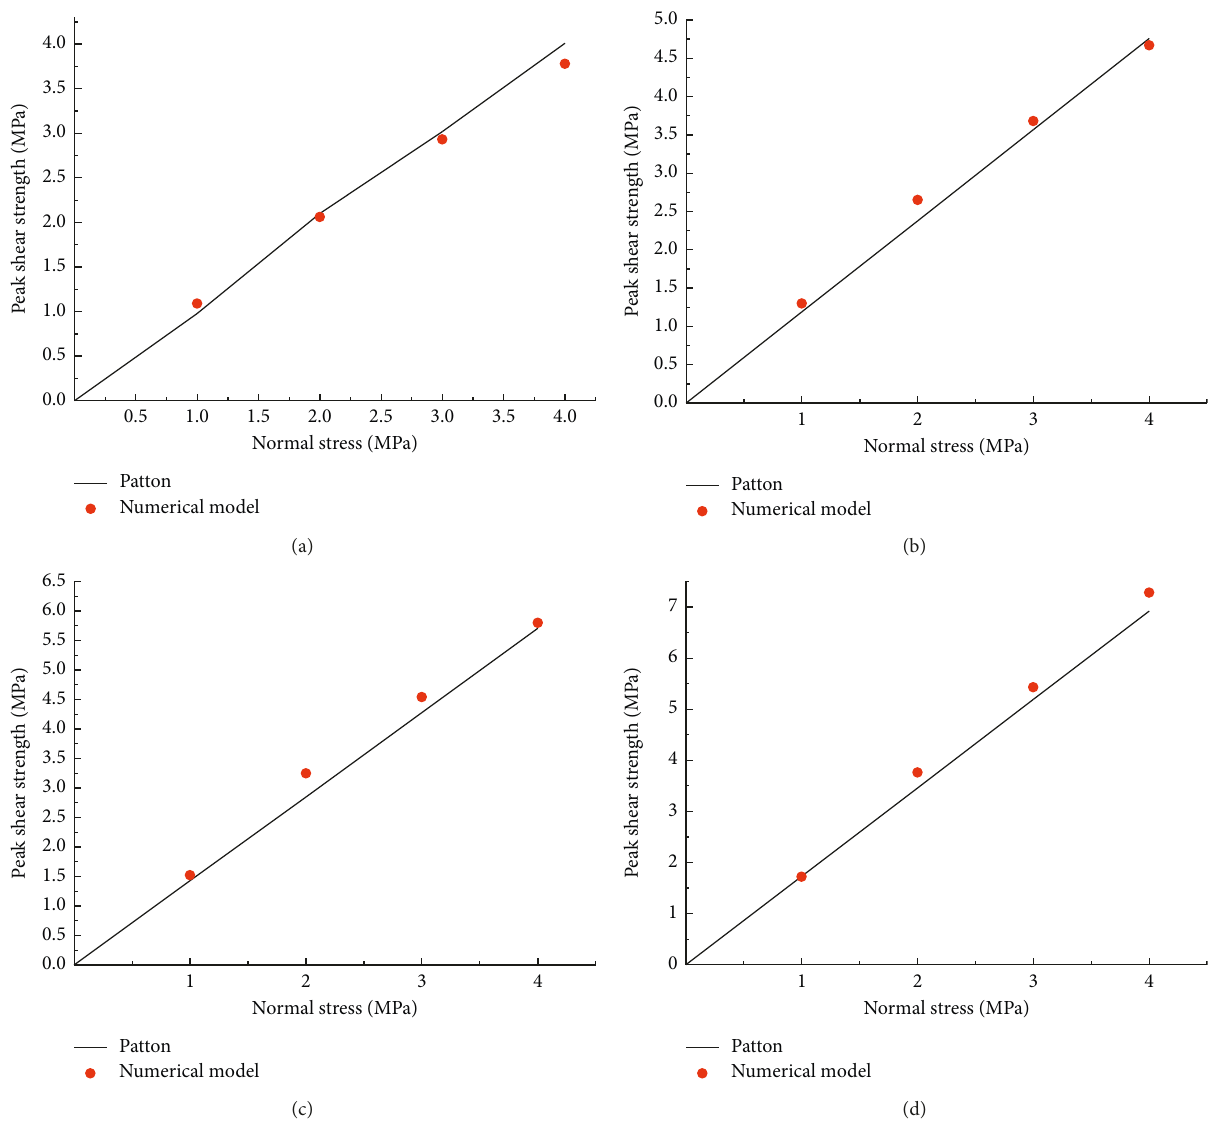
F IGURE 13: Comparison of the numerical and theoretical results for sawtooth joints. (a) i � 15 ° ; (b) i � 20 ° ; (c) i � 25 ° ; (d) i � 30 °